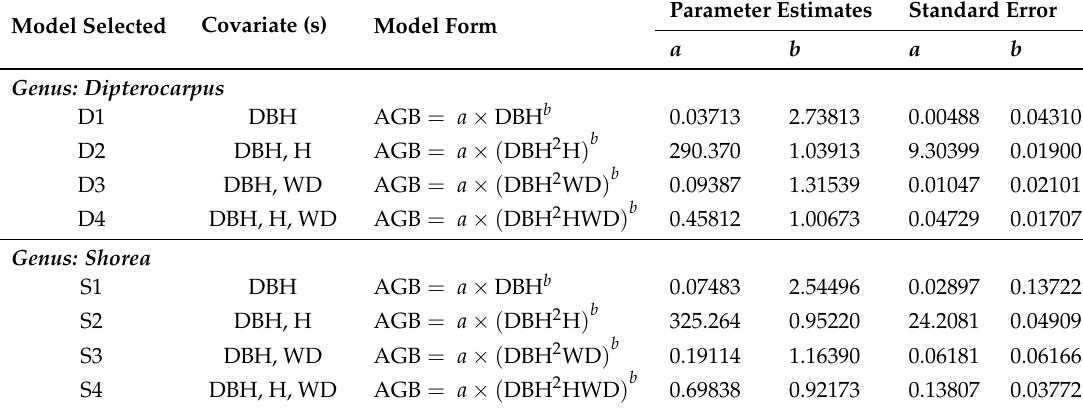
Table 6. Parameter estimates and their standard errors for the selected AGB models with different input variables for Dipterocarpus (the entire dataset, 94 trees) and for Shorea (the entire dataset, 36